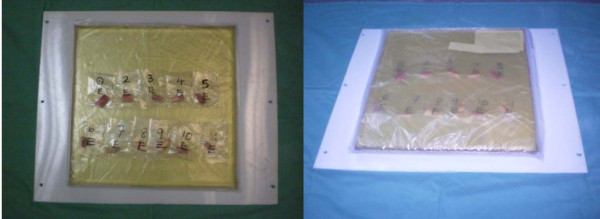
Cortical bone specimens placed in a board cover with a silicon pad layer before Irradiation.